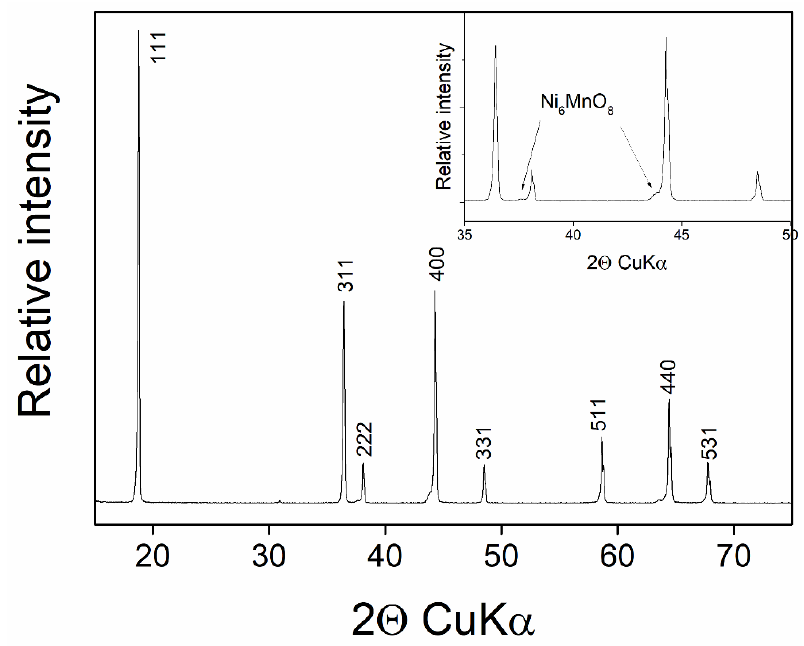
Figure 3. XRD pattern of synthesized LMNTO material.